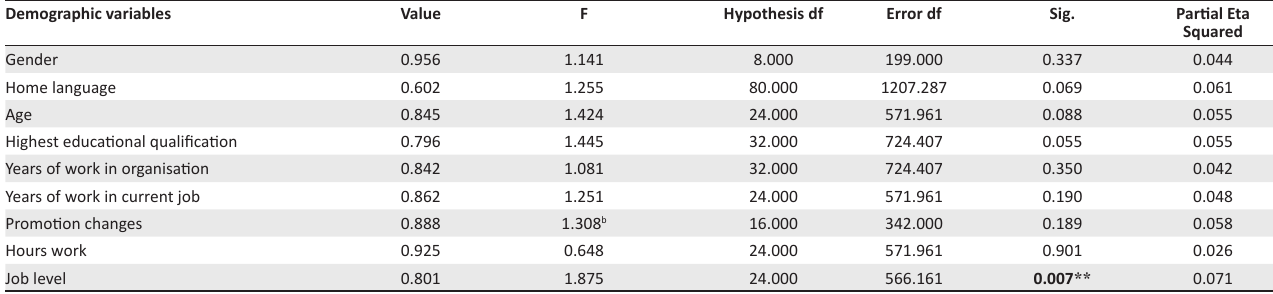
TABLE 3: Manova analyses between talent management and demographic